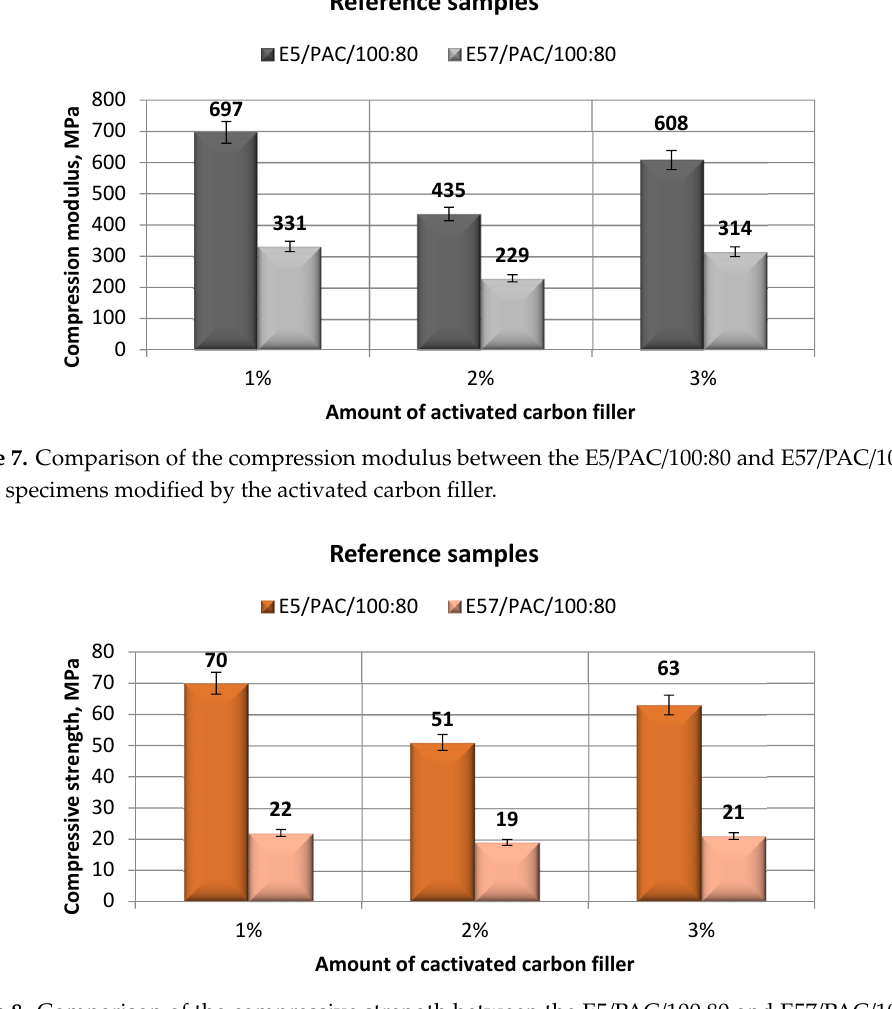
Figure 8. Comparison of the compressive strength between the E5 / PAC / 100:80 and E57 / PAC / 100:80 epoxy specimens modified by the activated carbon filler.